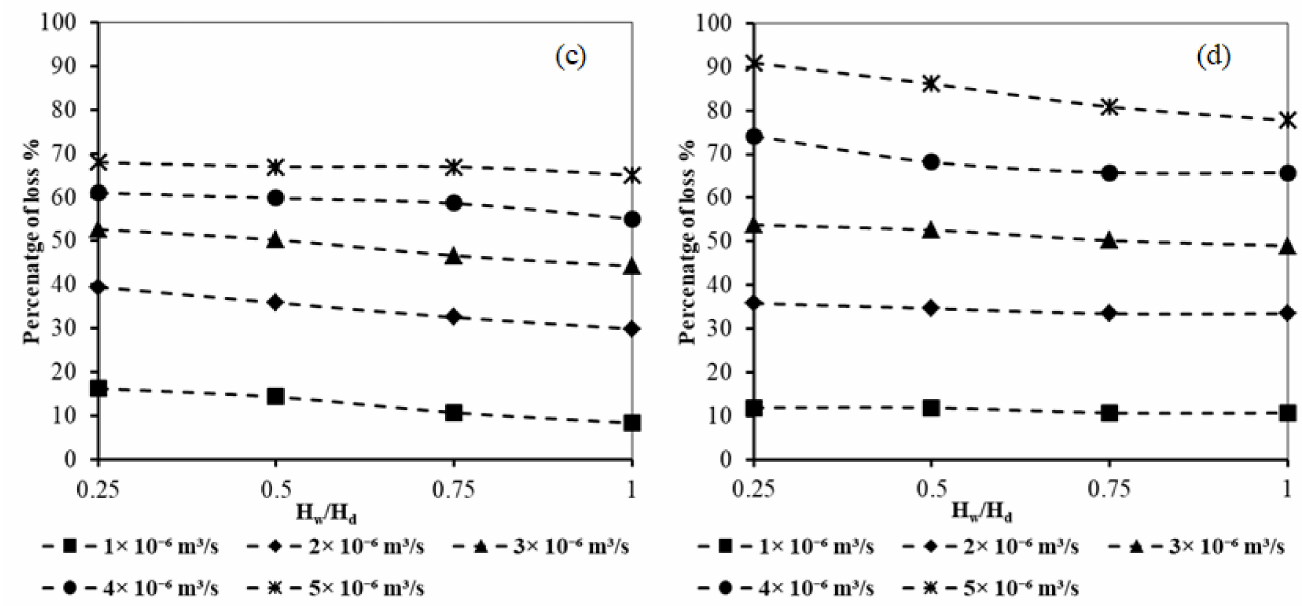
Figure 8. Relation between well height ratio and loss of subsurface dam effectiveness for L d = 0.50 m and D f = 0.01 m for: ( a ) L w /L d = 1.0 and H F = 0.1, ( b ) L w /L d = 2.0 and H F = 0.1, ( c ) L w /L d = 1.0 and H F = 0.2, ( d ) L w /L d = 2.0 and H F =